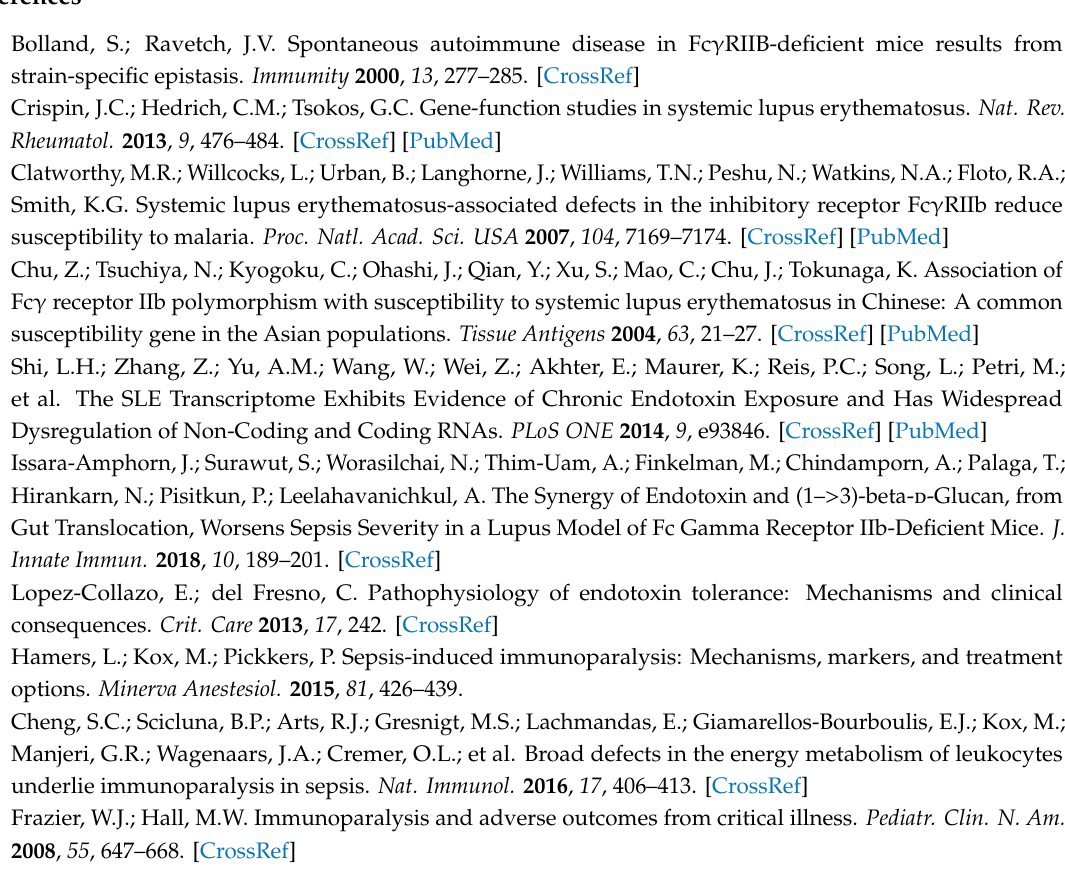
Figure S1: The characteristics of bone marrow derived macrophage from wild-type (FcGRIIb +/+ ) and FcGRIIb- / - mice with once LPS stimulation (N / LPS) as determined by supernatant cytokines (A-C) and Lipocalin-2